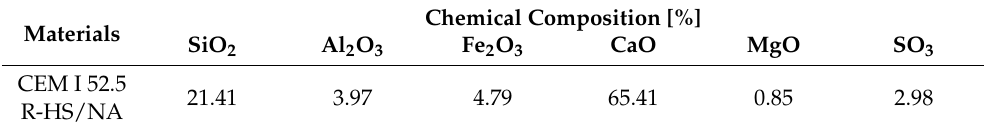
Table A2. Chemical properties of cement CEM I 52.5 R-HS/NA.